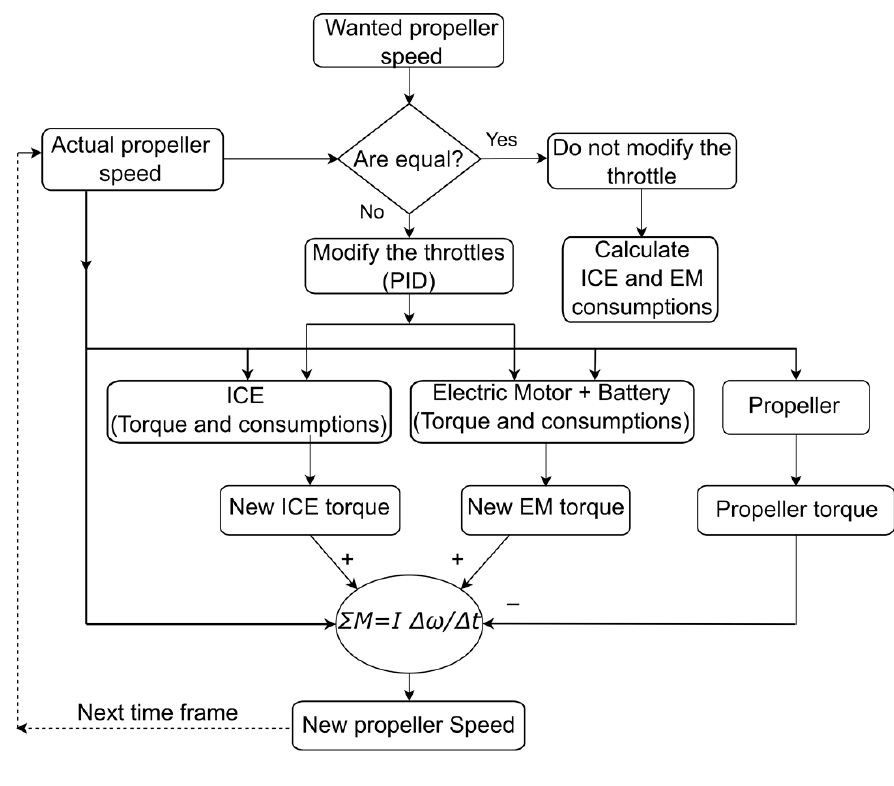
Figure 3. Model logic scheme. Table 3. Moment of